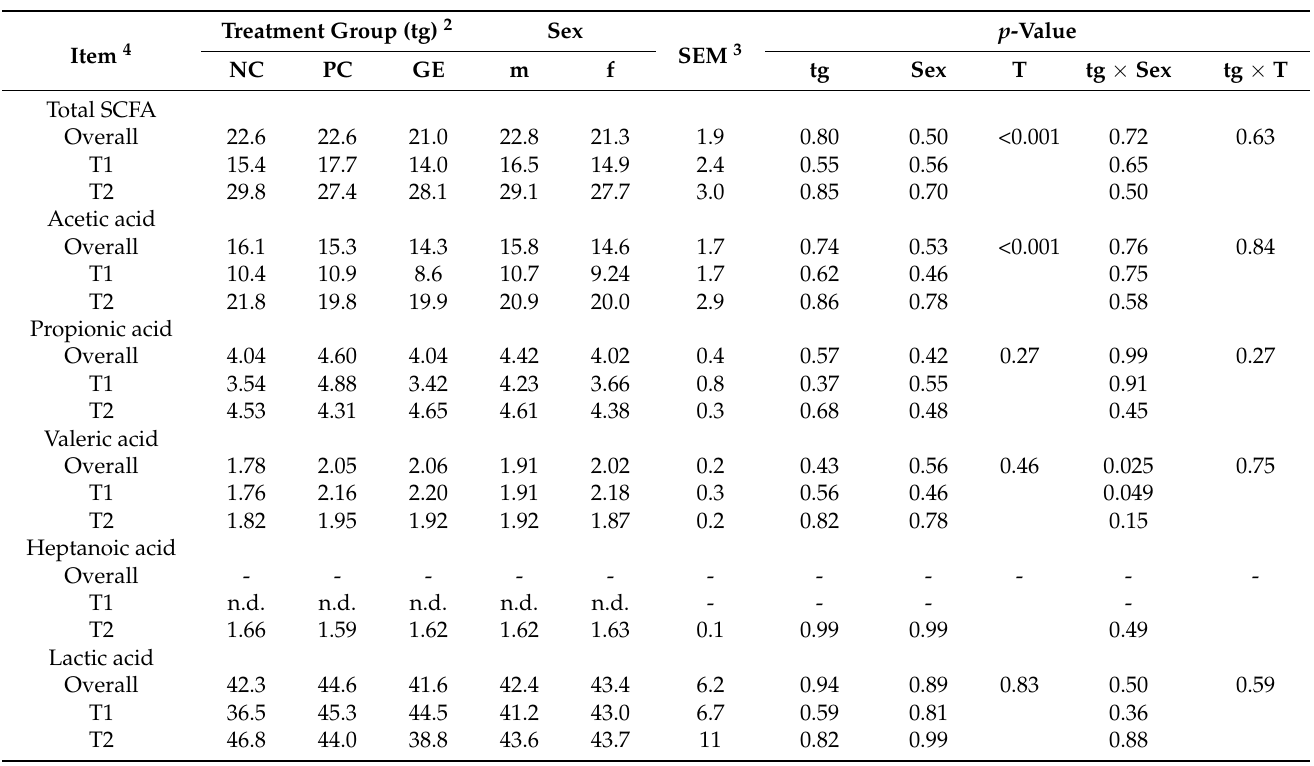
Table 5. Effect of using NC and PC for testing dietary GE supplementation on the concentrations of SCFA (mmol/kg) and lactic acid (mmol/kg) in ileal content of weaning piglets in two different sampling points 1 .